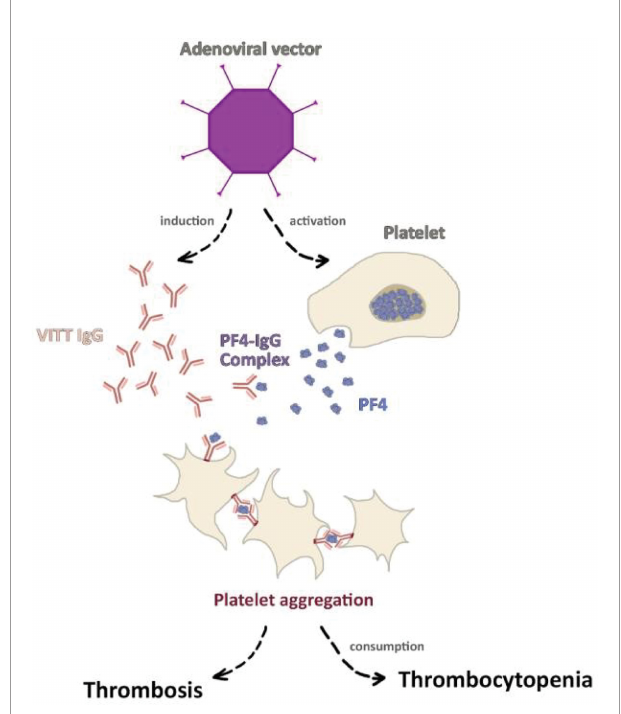
FIGURE 1 | The pathogenesis of vaccine-induced immune thrombotic thrombocytopenia (VITT). Vector-based COVID-19 vaccines, particularly ChAdOx1 COVID-19 vaccine was shown to induce platelet activation alongside platelet factor 4 (PF4) autoantibodies formation. The activated platelets secret greater amount of PF4 which binds to autoantibodies forming the PF4-IgG complex. As a result, Fc g RIIA receptor mediated platelet activation leads to widespread thrombosis and secondary